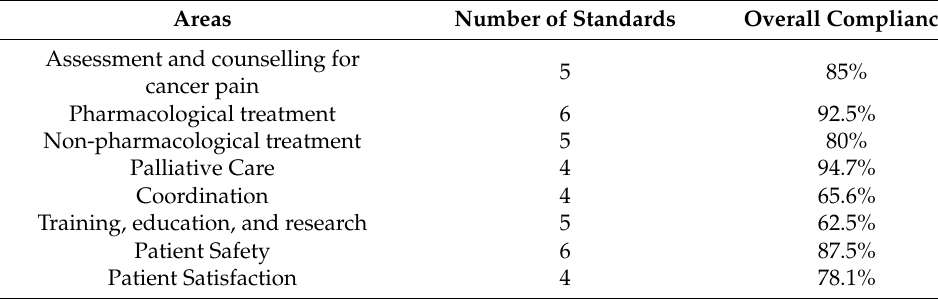
Table 3. Compliance of standards according to areas.